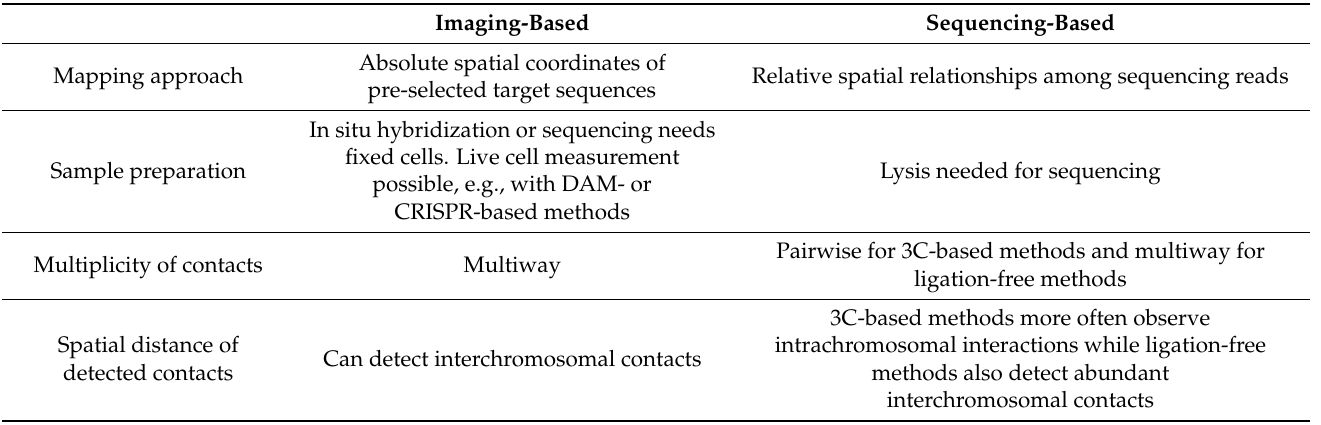
Figure 5. A cartoon illustration of the cell-type-specific enhancer–promoter interactions linking GWAS variants to their putative target genes: ( A ) The complex tissue consists of four cell types (A, B, C, and D), where cell types A (red) and B (yellow) are disease relevant, cell types C (blue), and D (green) are not disease relevant. ( B ) Two GWAS variants SNP1 and SNP 2 (highlighted by the red star) locate upstream of gene X and downstream of gene Y (genes are shown as blue cylinders). In cell type A, SNP 1 resides in cell-type-A-specific enhancer E.A (highlighted by the yellow cylinder), interacting with the promoter of gene X (P.X, highlighted by the green cylinder). In cell type B, SNP 2 resides in cell-type-B-specific enhancer E.B (highlighted by the yellow cylinder), interacting with the promoter of gene Y (P.Y, highlighted by the green cylinder). In cell types C and D, neither SNP 1 and nor SNP 2 resides in enhancers, and there is no chromatin interaction between GWAS SNPs and gene promoters. In this cartoon illustration, gene X is the putative target of GWAS SNP 1 in cell type A, while gene Y is the putative target of GWAS SNP 2 in cell type B. Table 1. Summary of imaging- and sequencing-based